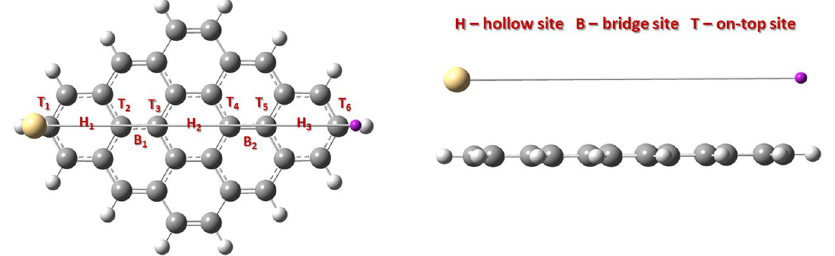
Figure 5. Path of the surface motion of the neutral generic HM atom on C 30 H 16 GQD.